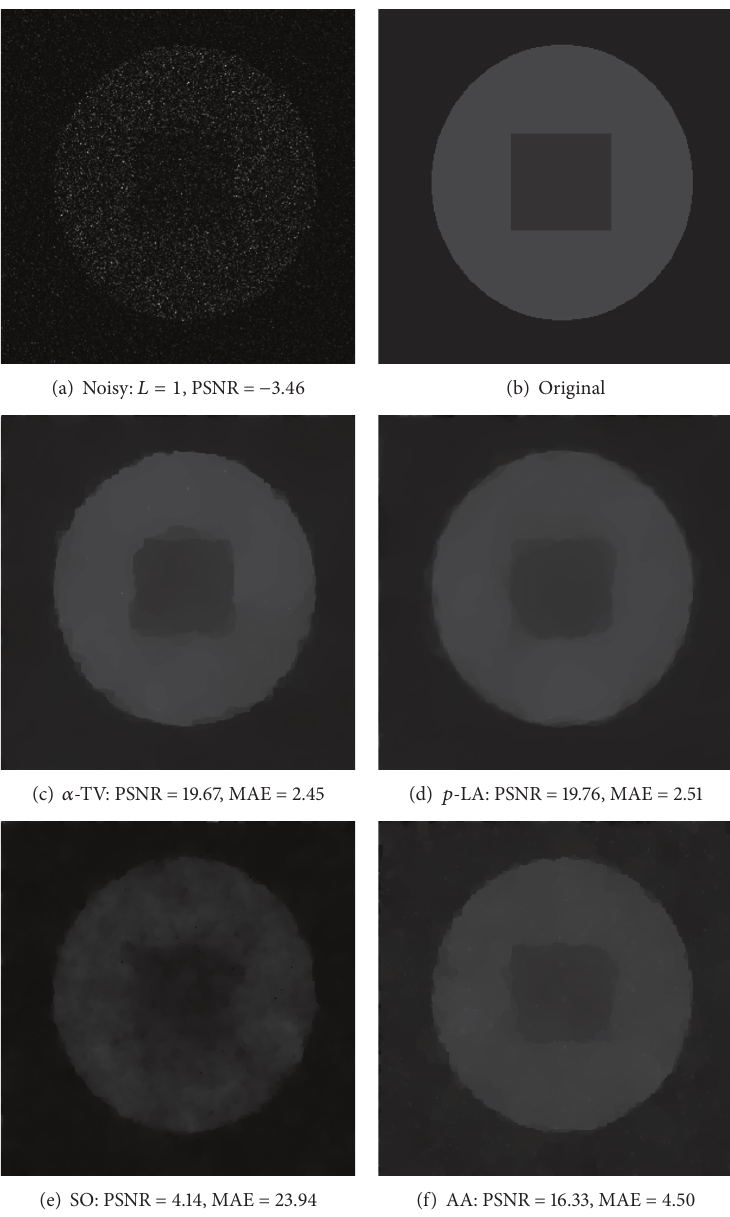
Figure 2: Synthetic image ( 300 × 300 ). (a) Noisy image corrupted by speckle noise for 𝐿 = 1 in (8). (b) Original image. (c) Our algorithm by = 1.3 . (e) SO algorithm, 𝜆 = 0.1 , 𝛼 = 0.25 . (f) AA algorithm, 𝜆 = 50 𝛼 -TV, 𝜎 = 2 , 𝑘 = 0.05 , and 𝜏 = 0.05 . (d) Our algorithm by 𝑝 -LA, 𝑝 𝑈